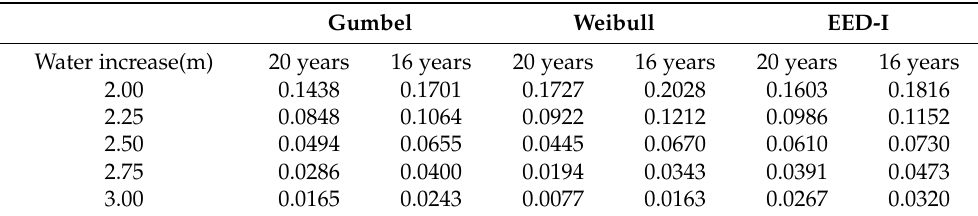
Table 4. Comparison of fitting results of different probability density functions to water increase tail